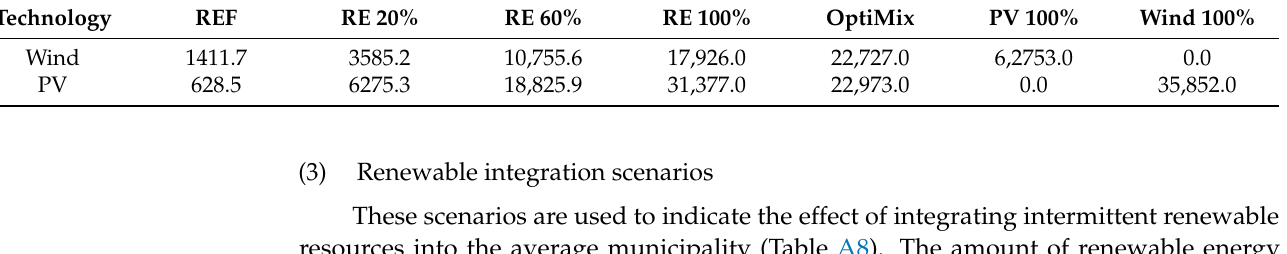
Table A7. Installed capacity in kW of renewable resources in renewable integration scenarios.